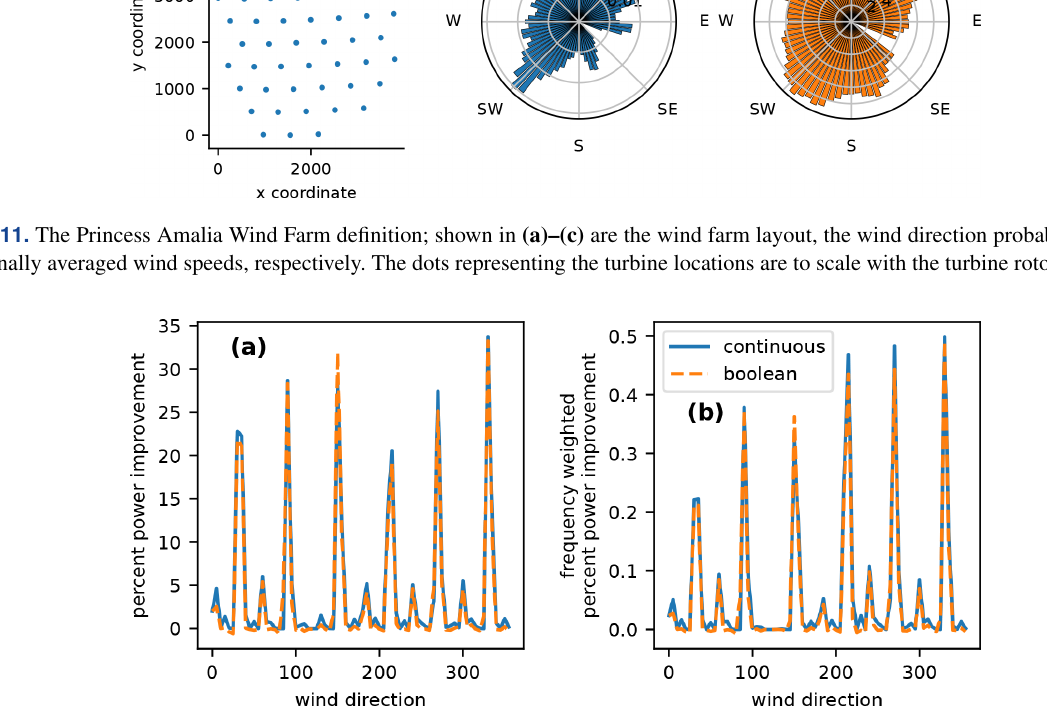
Figure 12. Power improvements achieved by yaw control in the Princess Amalia Wind Farm compared to an unyawed baseline. The different colored lines represent the results from the continuous optimization and our new Boolean yaw optimization indicated by the legend. (a) The percent power improvement for each wind direction and (b) the same percent improvements multiplied by the probability of the associated wind direction.